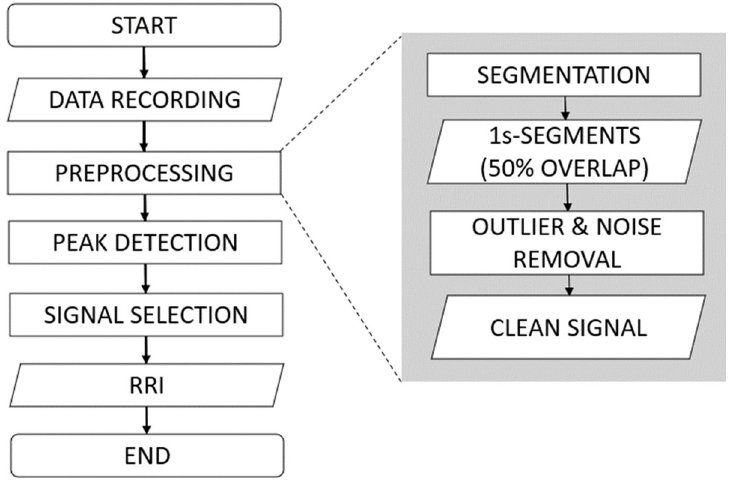
Fig 4. Analysis flowchart. Validation is based on the output RRI.